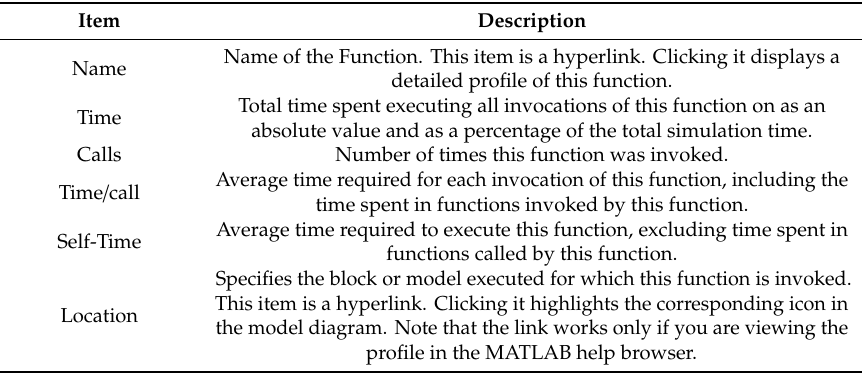
Table 5. Description of the fields for the single block.